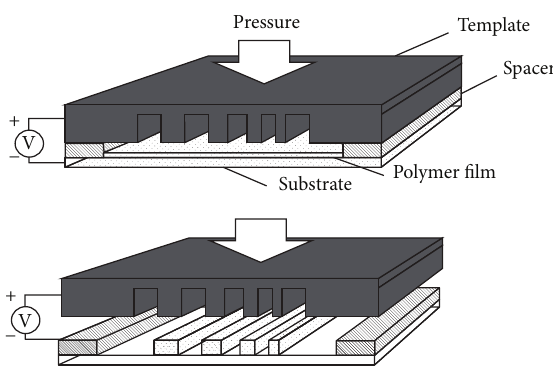
Figure 1: The schematic diagram of EHD patterning using the template with arbitrary